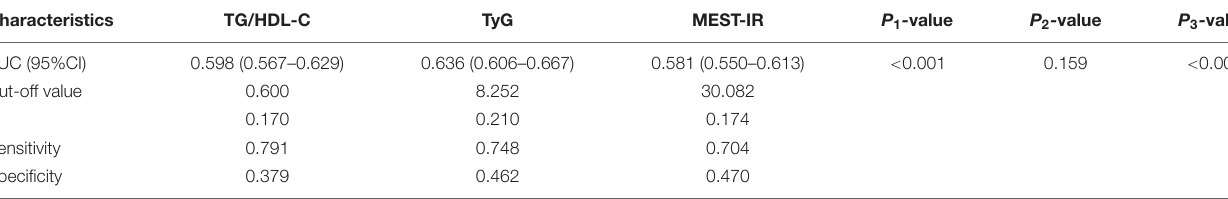
FIGURE 3 | Receiver-operating characteristic curves showing the ability of TG/HDL-C, TyG, and METS-IR to detect increased arterial stiffness (CAVI ≥ 8.0). CAVI, cardio–ankle vascular index; TG/HDL-C, triglyceride to high-density lipoprotein cholesterol ratio; TyG, fasting triglyceride and glucose index; METS-IR, metabolic score for insulin resistance. TABLE 6 | The ROC curves analysis of TG/HDL-C, TyG, and METS-IR index for discriminating CAVI ≥ 8.0.